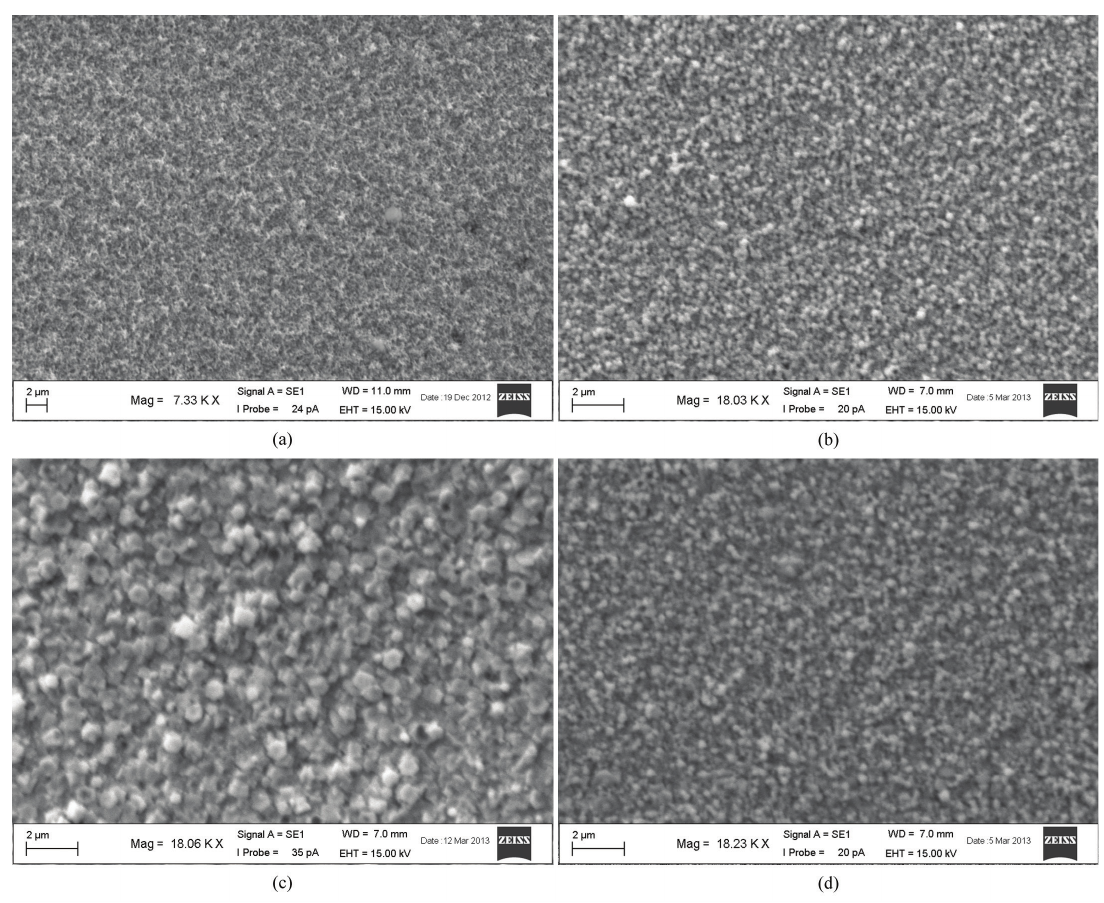
Figure 3. SEM micrographs of (a) undoped CdO, (b) 0.06% Be-doped CdO, (c) 0.1%Be-doped CdO, and (d) 0.12% Be-doped CdO